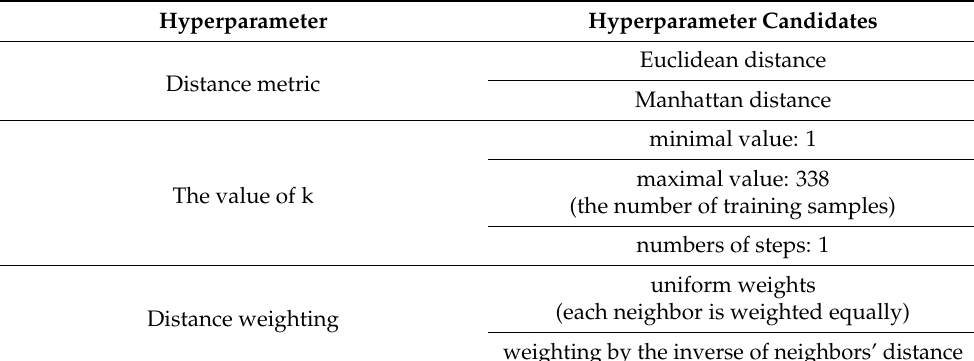
Table 2. The hyperparameter space of